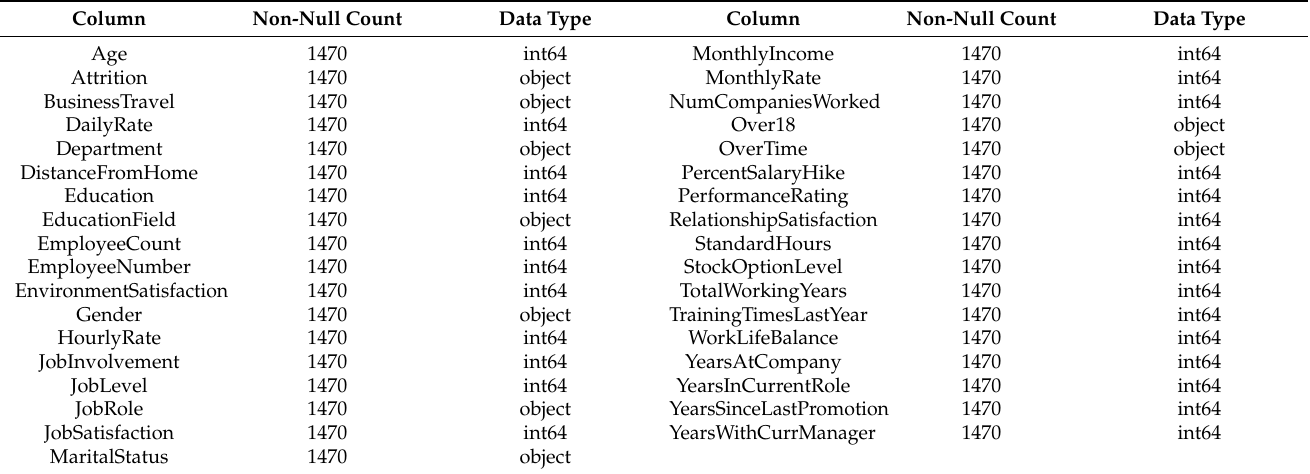
Table 1. The dataset feature analyses and related information.